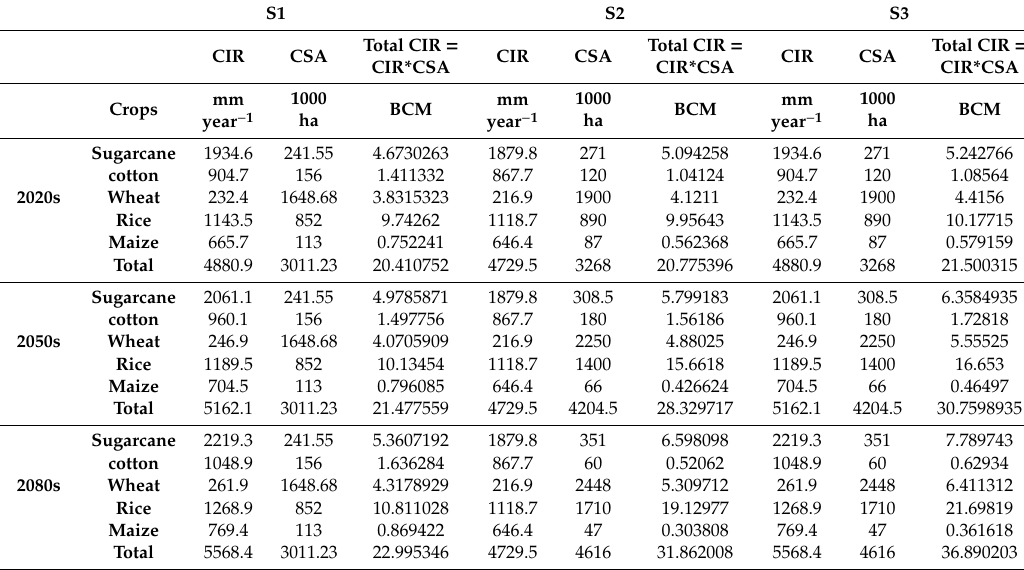
Table 6. Total CIR for di ff erent crops under the H3A2 scenario with three di ff erent sub-scenarios S1, S2, and S3. * Note: CSA indicated crop sown area.